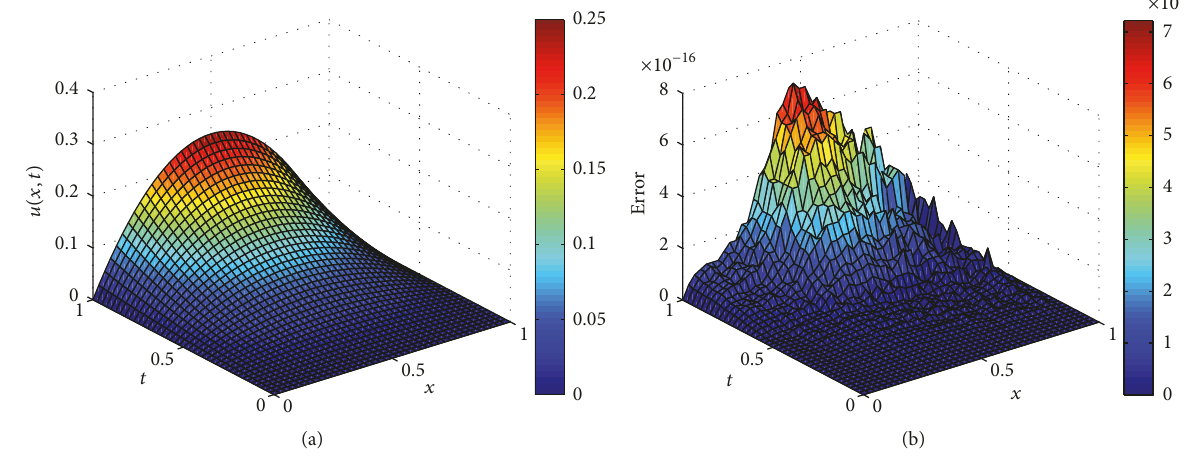
Figure 1: Approximate solution (a) and absolute error (b) for Example 1 with 𝛼 = 1.1 , 𝑘 = 2 , and 𝑀 = 3 . Table 1: The absolute error for Example 1 for some different values 1 < 𝛼 ≤ 2 at some different points.